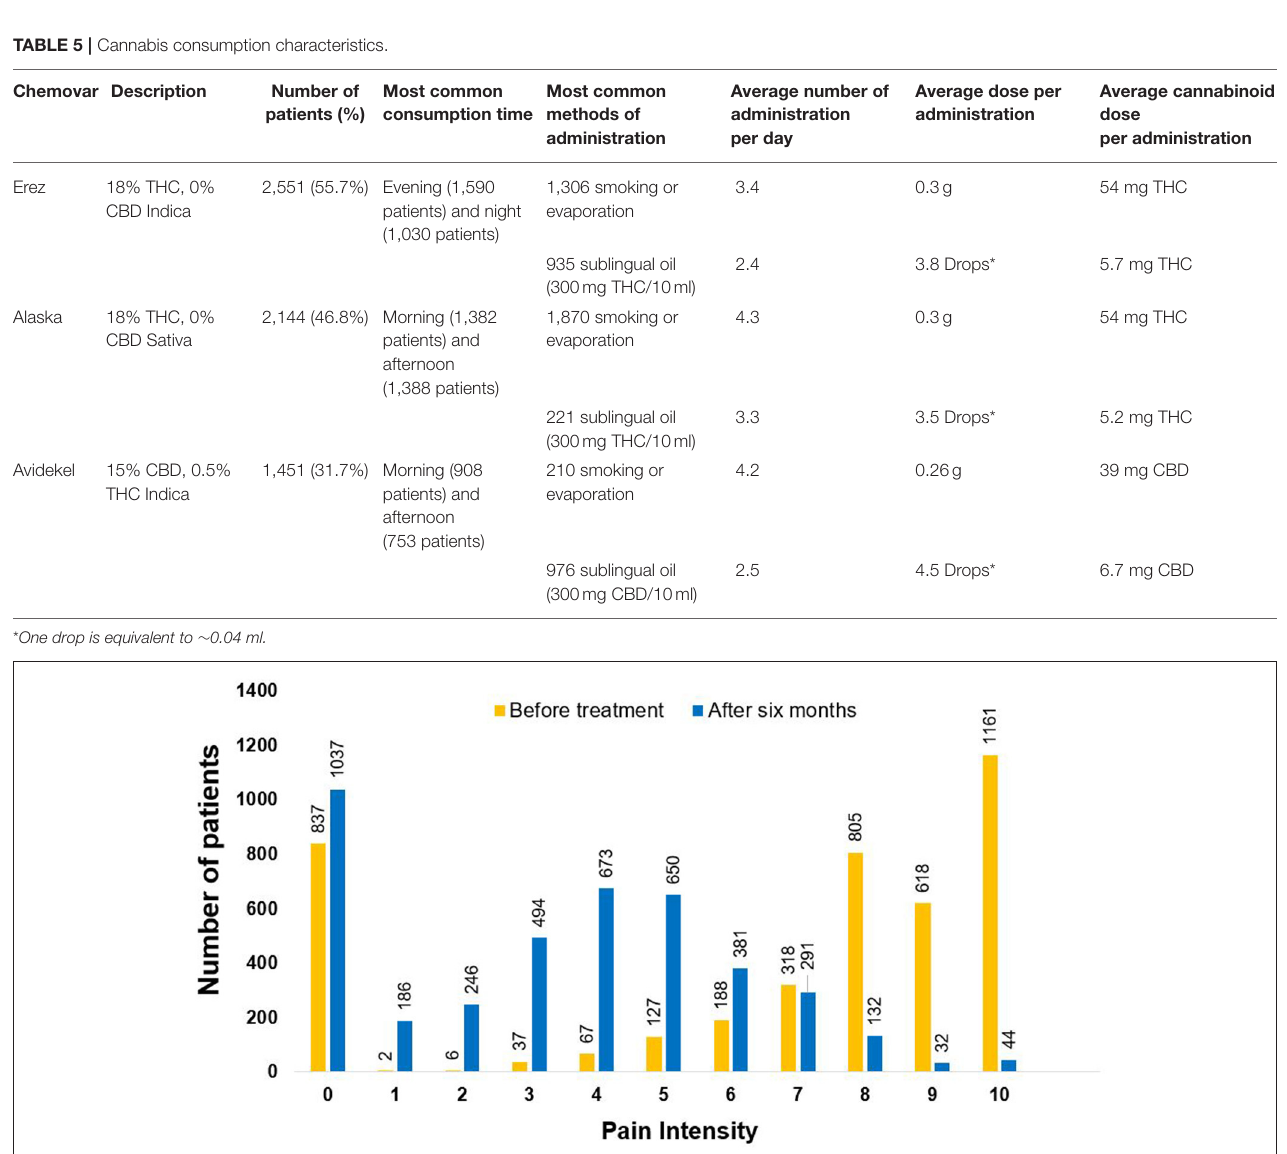
TABLE 5 | Cannabis consumption characteristics. Chemovar Description Number of